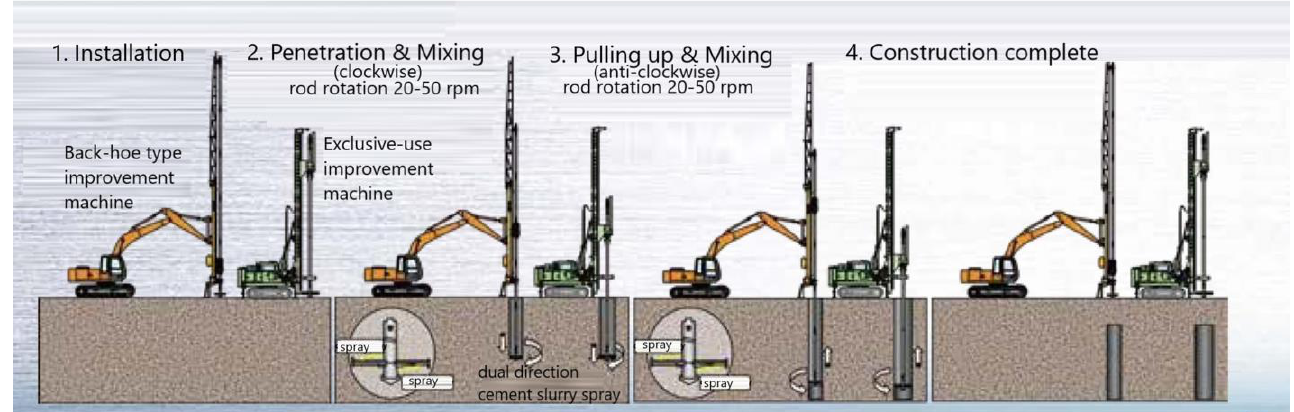
Figure 1. Mechanical agitation and mixing jet-grouting construction.